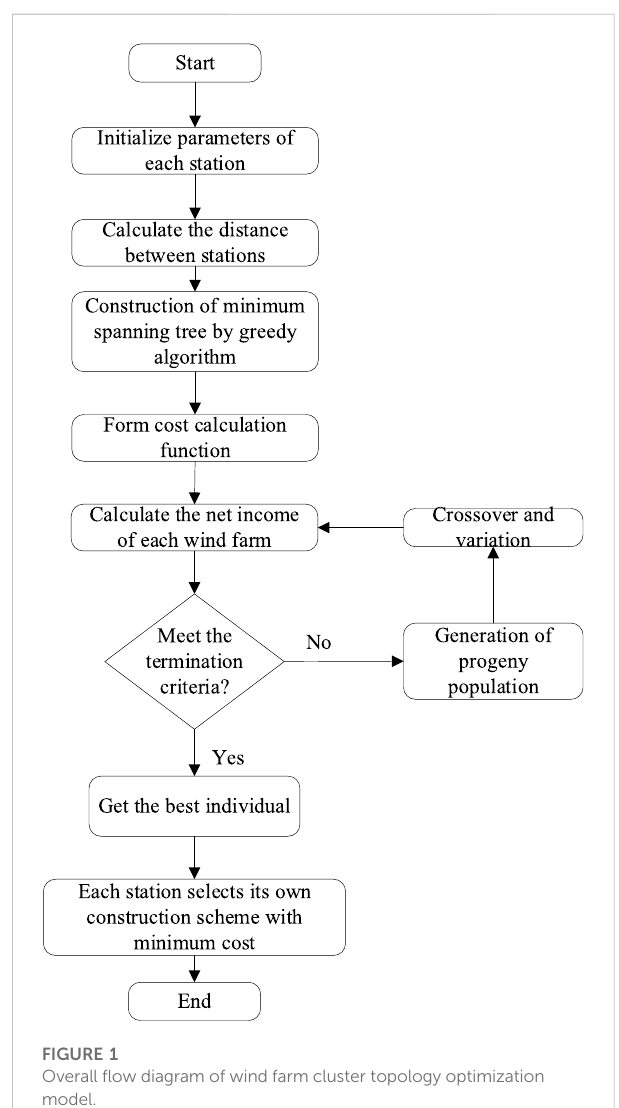
FIGURE 1 Overall fl ow diagram of wind farm cluster topology optimization